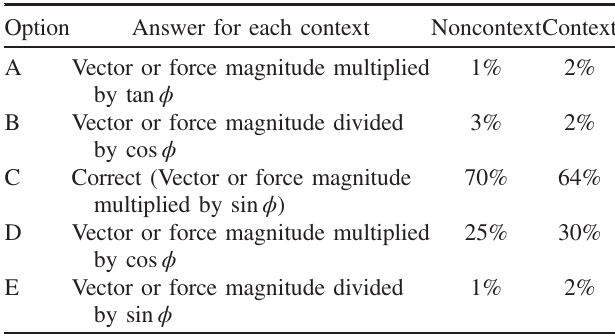
TABLE X. Results of item 10: Students have to calculate the x component of a vector or force (angle ϕ measured from y axis).